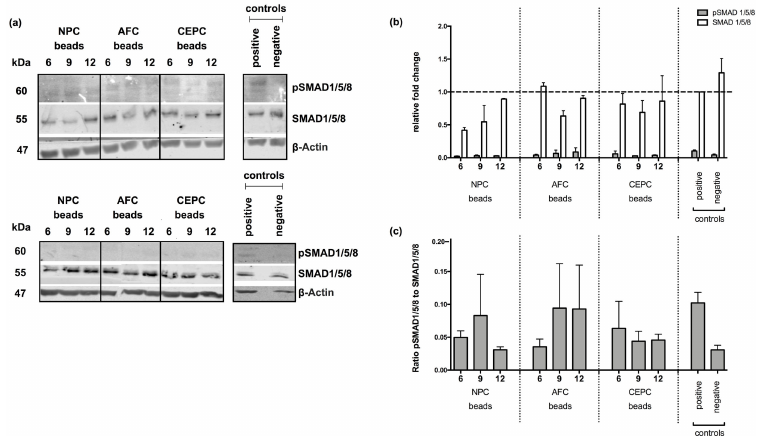
Figure 3. ( a ) Western blot and ( b ) fold change of SMAD and phospho-SMAD 1/5/8 (pSMAD1/5/8) normalized to actin and to positive control (=1.0) ( c ) ratio of pSMAD 1/5/8 and SMAD 1/5/8 of human primary osteoblasts (OB) co-cultured with 6, 9 or 12 alginate beads of human primary nucleus pulposus cells (NPC), annulus fibrosus cells (AFC), cartilaginous endplate cells (CEPC) or 6 empty beads (positive control) and negative control. All experimental groups were stimulated with osteogenic medium except negative control, where OB were cultured with basal medium. Cells were lysed at day 10. Values in ( b , c ) are means ± standard error of mean (SEM), N =